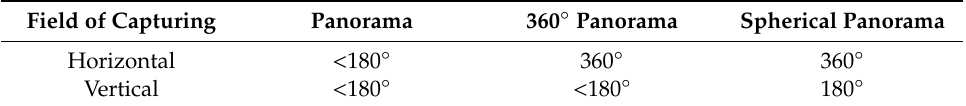
Table 1. Classification of Panorama